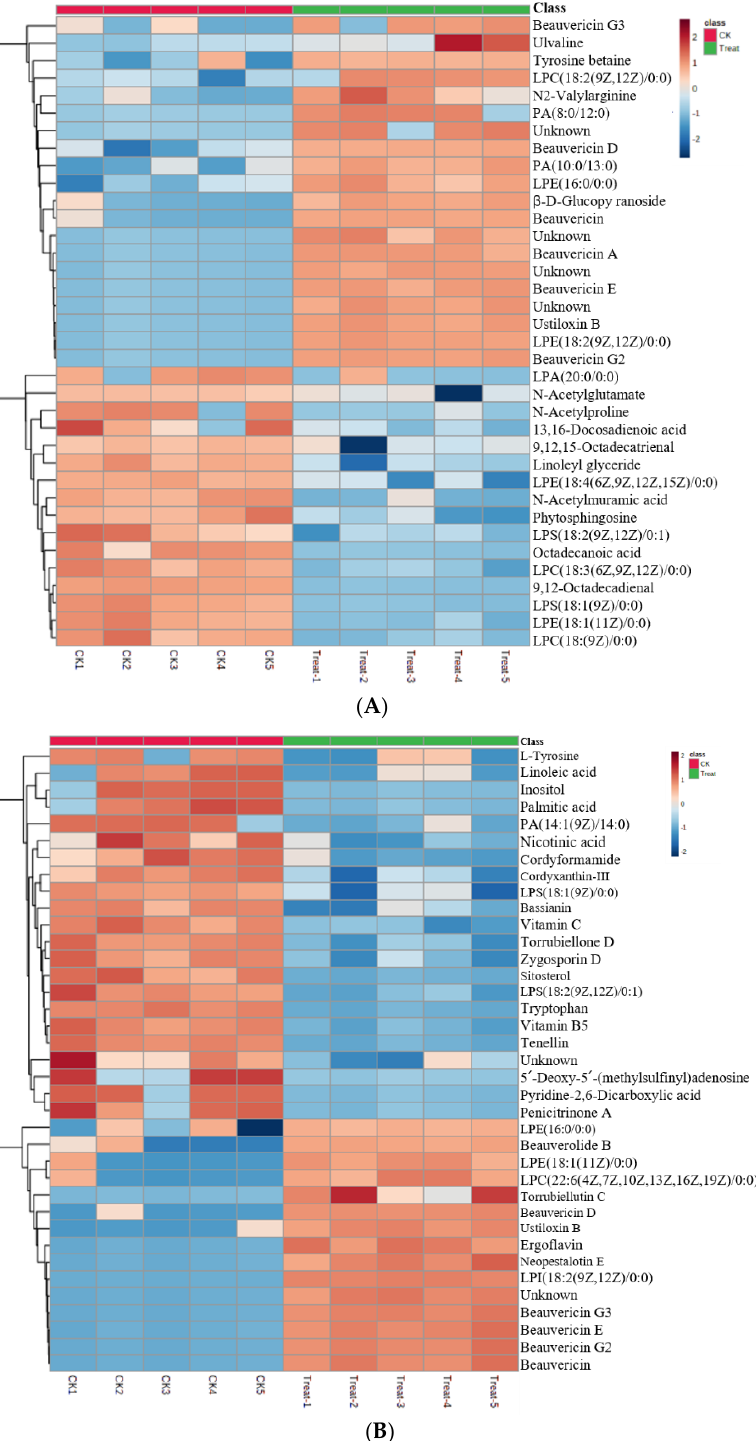
Figure 3. ( A ) Heat map of differential metabolites in positive ionization mode under oxidative stress induced by H 2 O 2 . ( B ) Heat map of differential metabolites in negative ionization mode under oxidative stress induced by H 2 O 2 . CK, control, without H 2 O 2 ; Treat, with H 2 O 2 , and 1 − 5 represent biological repetitions.